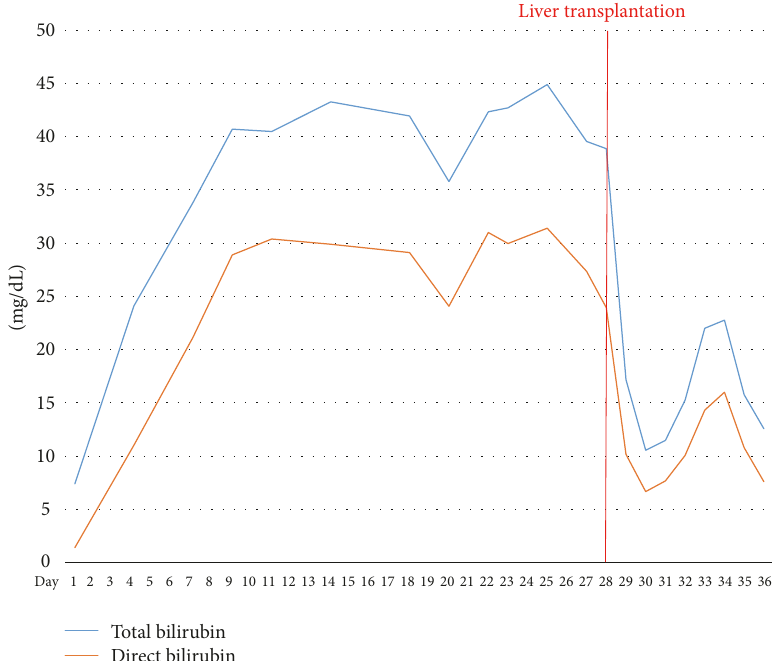
Figure 2: Trend of bilirubin levels.